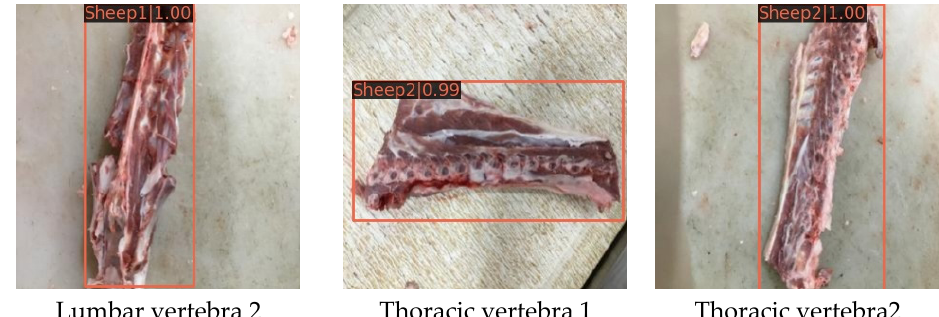
Figure 12. Partial results of model robustness testing in this paper.